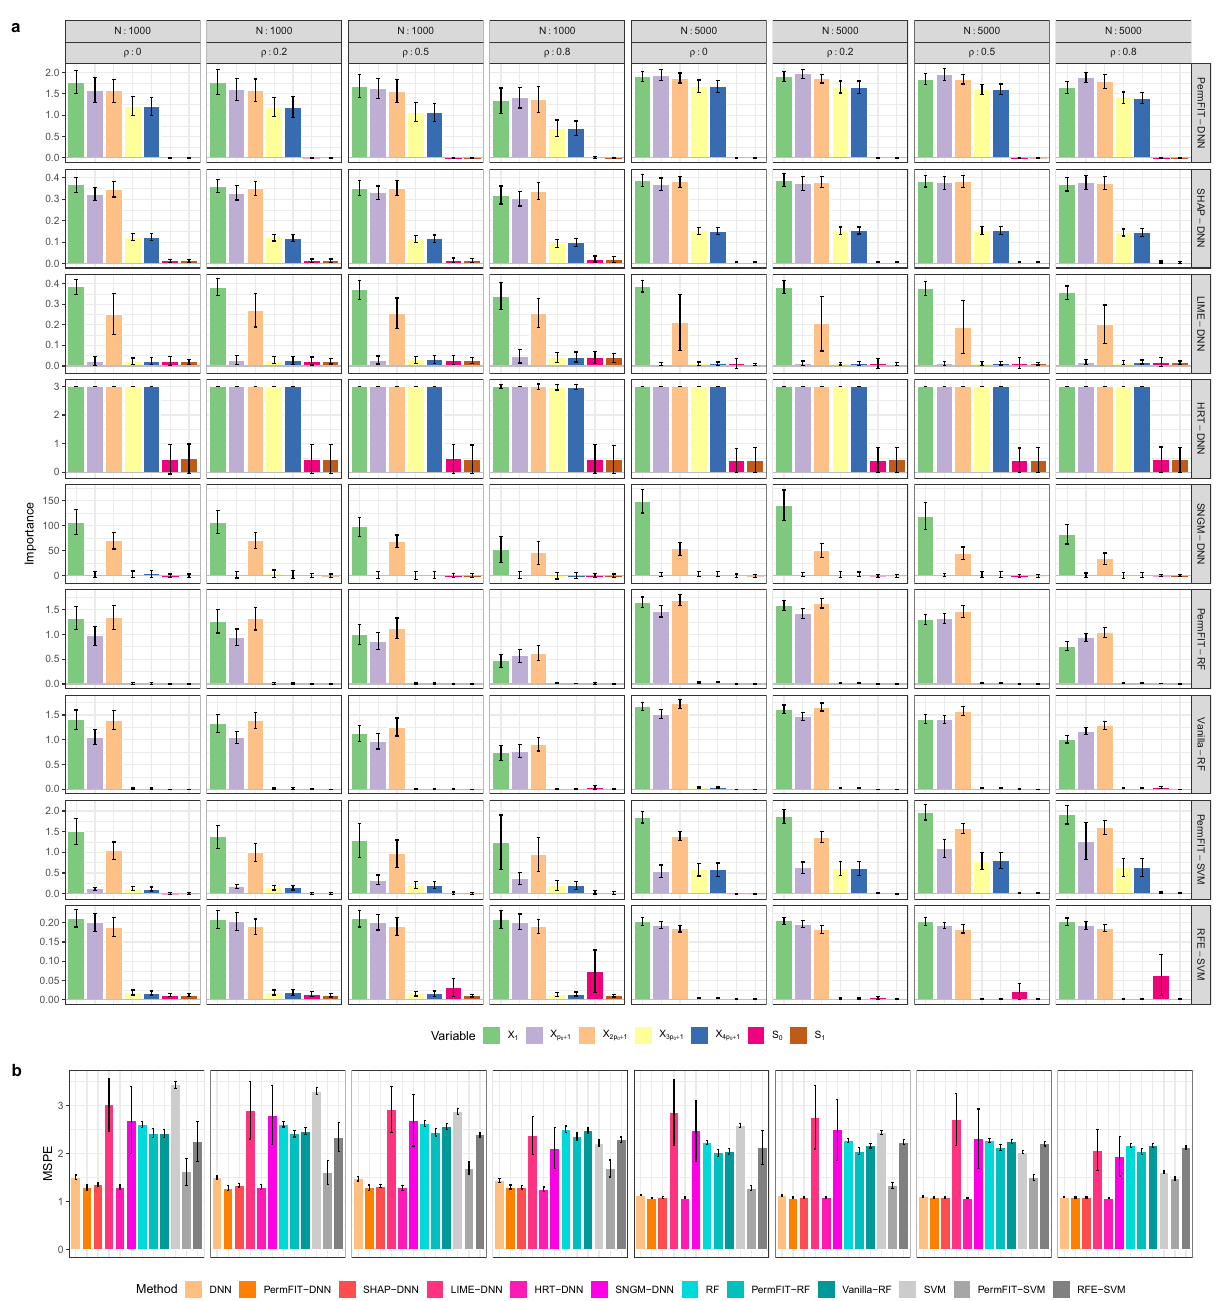
, X 2 p , X 3 p , X 4 p , and 0 þ 1 0 þ 1 0 þ 1 0 þ 1 extracted from reverse phase protein arrays (RPPAs) — a highly sensitive, reproducible, and high-throughput proteomic method for protein expression pro fi ling 28 . ( p value)s and the estimated importance The negative log 10 scores from each method are presented in Fig. 2 and Supplementary Fig. 3. HRT-DNN, Vanilla-RF and PermFIT models control the FDR at 0.1, and SHAP-DNN, LIME-DNN, SNGM-DNN and RFE-SVM selects 10 features with the largest importance scores. We notice that moderate correlations generally exist among the proteins (see Supplementary Fig. 2).